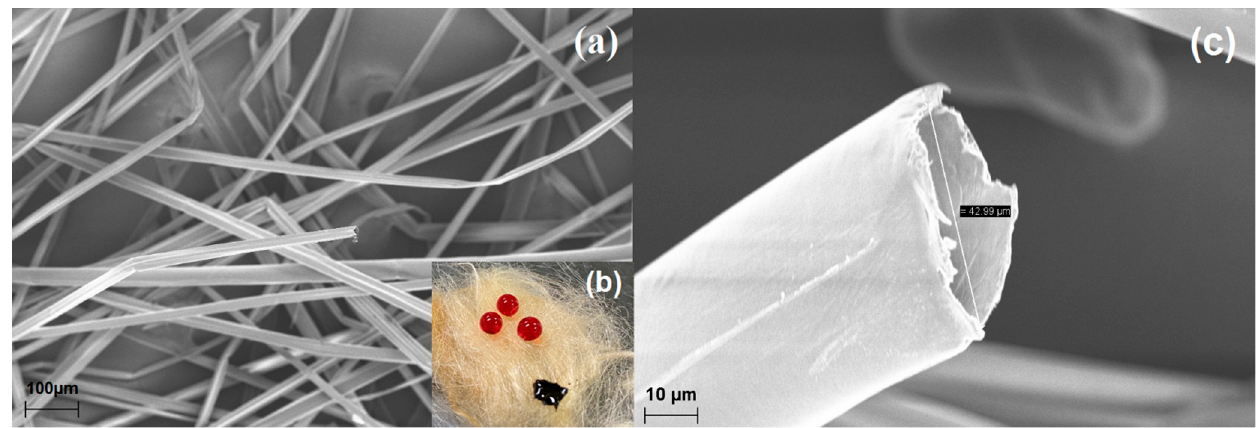
Figure 8. Micrograph obtained by the ( a ) SEM-FEG 100×, ( b ) digital image of the wettability test, and ( c ) SEM-FEG 1000× in CPNaOHT.